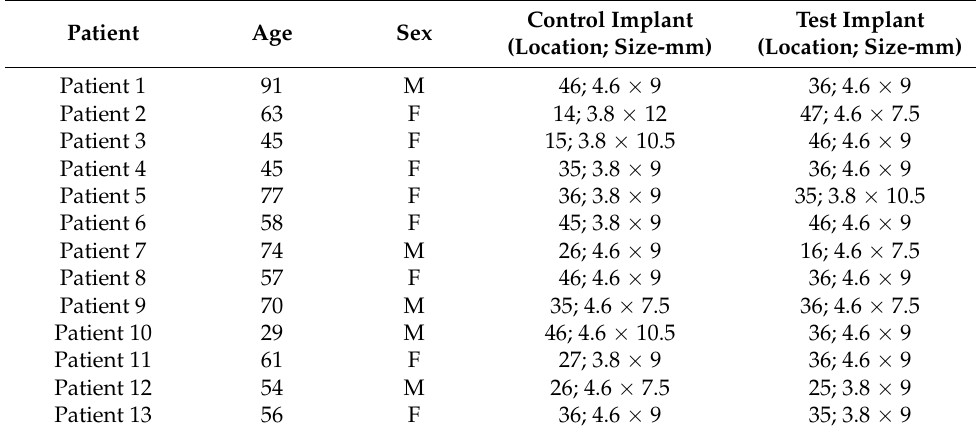
Table 1. Patient demographics, site and size of the implants.